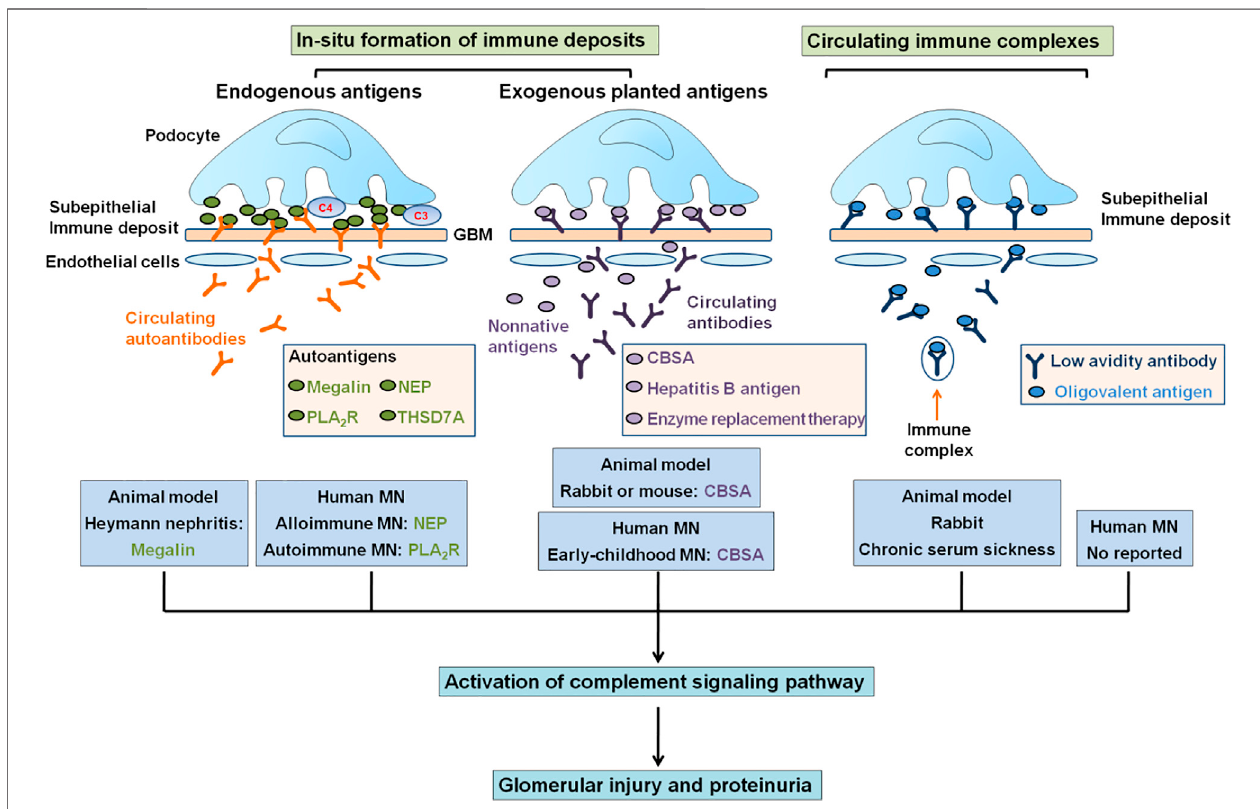
FIGURE 1 | Mechanisms of formation of subepithelial immune complex deposits. The depositions of subepithelial immune complexes might form either in situ immune complexes or circulating immune complexes that contained circulating antibodies binding to endogenous antigens (megalin, NEP, PLA 2 R, and THSD7A) in podocytes or to exogenous antigens (CBSA, hepatitis B antigen, and enzyme replacement therapy) planted in GBM. In total, four endogenous antigenic targets have been identi fi ed, including megalin in Heymann nephritis, NEP in alloimmune neonatal MN, and PLA 2 R and THSD7A in IMN. In total, four circulating exogenous antibodies can target surface-exposed intrinsic podocyte antigens to cause capping and shedding of in situ antigen – antibody complex into underlying GBM. CBSA, enzyme from enzyme replacement therapy, and hepatitis B antigen may traverse GBM and bind under podocyte as planted antigens and also as target for circulating antibodies. In addition, circulating immune complexes deposited in the subepithelial